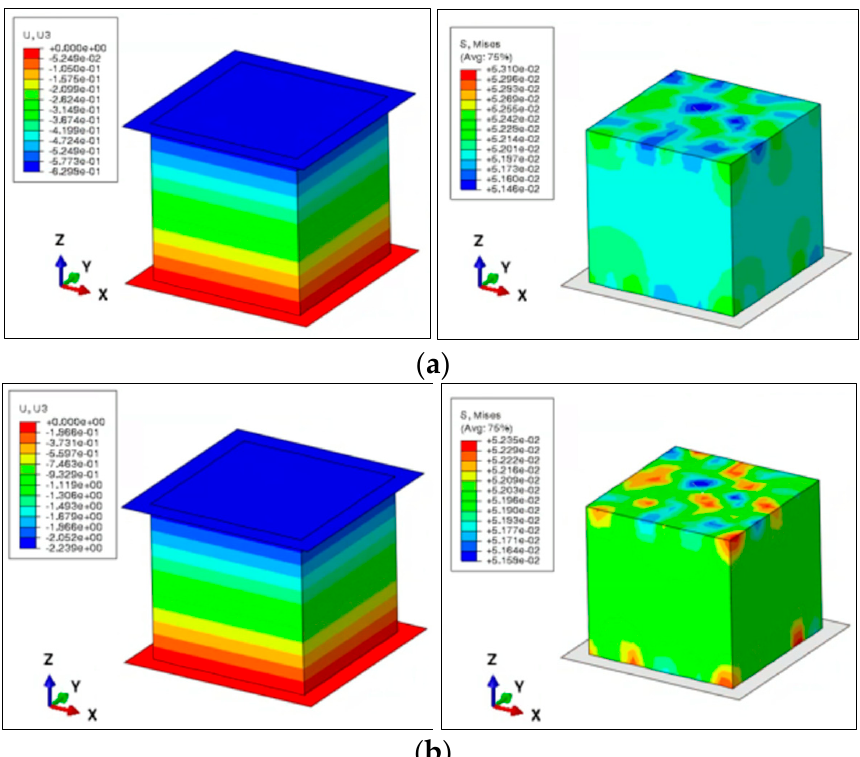
Figure 10. Example of the stress and displacement distribution by step in the FEA: ρ = 18 kg/m 3 , σ o = 0.0520 MPa. ( a ) the end point of step 1: ( left ) displacement, ( right ) stress. ( b ) the end point of step 2: ( left ) displacement, ( right ) stress.